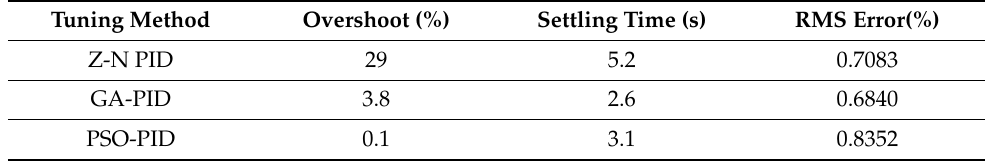
Table 2. Step Response Performance for PID